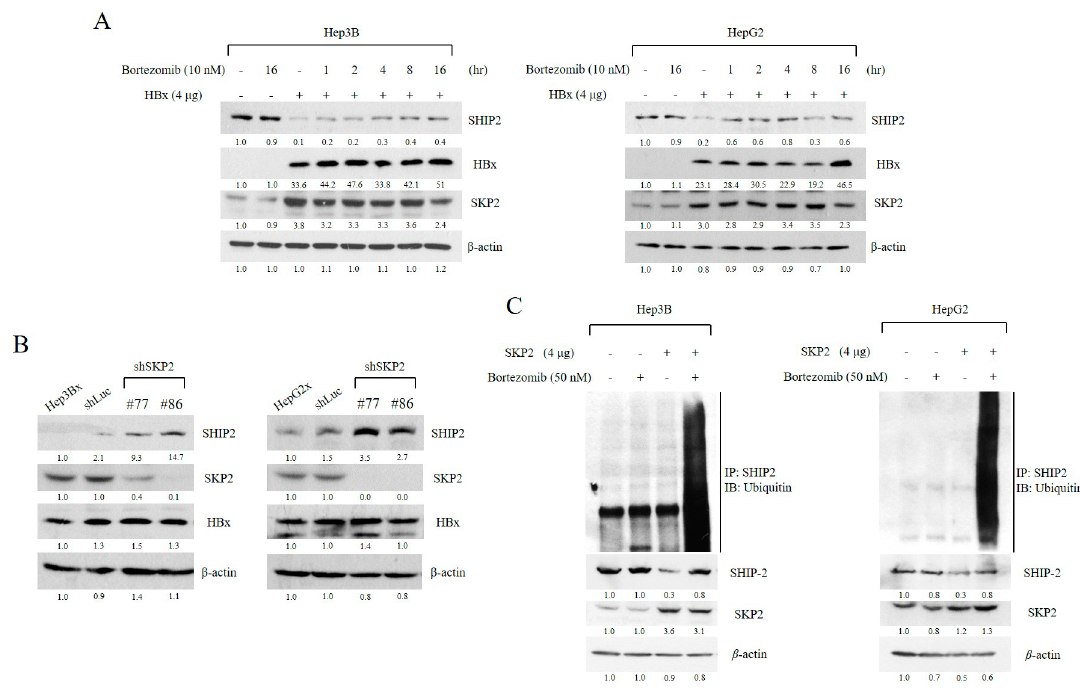
Figure 3. SHIP2 is polyubiquitinated by the E3 ubiquitin ligase SKP2 in HCC cells. ( A ) Time-dependent study of the e ff ect of bortezomib (10 nM) treatment on SHIP2 expression in HBx-transfected HCC cell lines. SHIP2, HBx, and S-phase kinase-associated protein 2 (SKP2) were analyzed by western blotting. ( B ) Hep3Bx and HepG2x cells were infected with lentivirus for delivery of short-hairpin RNA (shRNA) against luciferase (shLuc) or SKP2 (shSKP2) for three days, and then whole-protein lysates were analyzed by western blotting. ( C ) Hep3B and HepG2 cells were transiently transfected with SKP2 or control expression vector for 48 h and then were treated in the absence or presence of bortezomib (50 nM) for 16 h prior to cell harvest. Whole-protein lysates were prepared followed by immunoprecipitation (IP) with anti-SHIP2. The precipitate was then electrophoresed on a polyacrylamide gel followed by immunoblotting (IB) using anti-ubiquitin. The whole blot has been provided as Supplemental Materials (Figure S5).